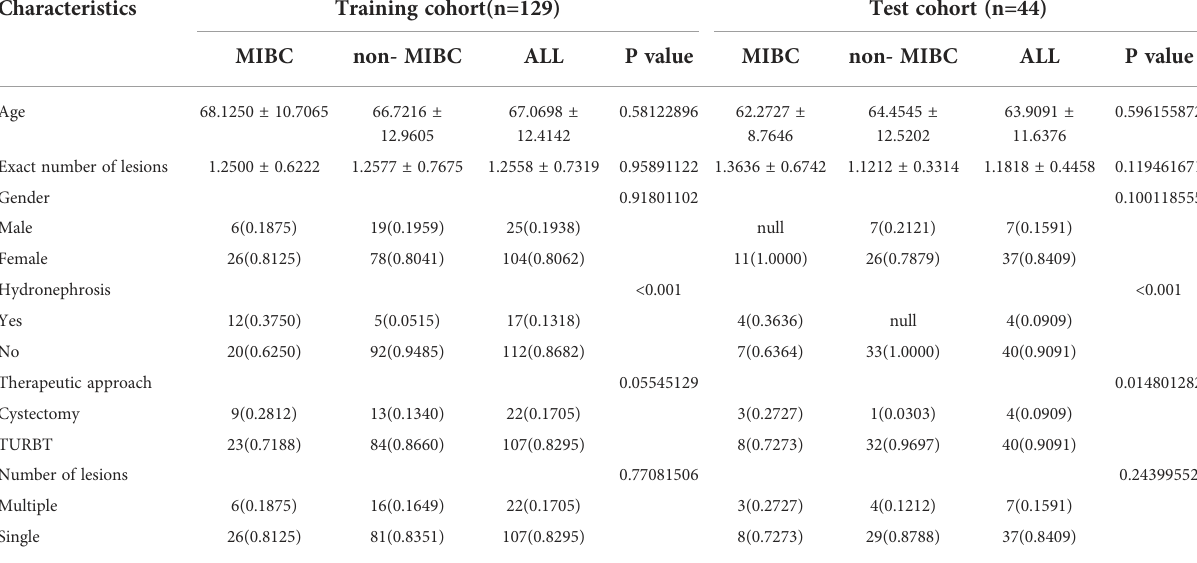
TABLE 1 Comparison of the clinical characteristics of the enrolled patients in the training and test sets. Characteristics